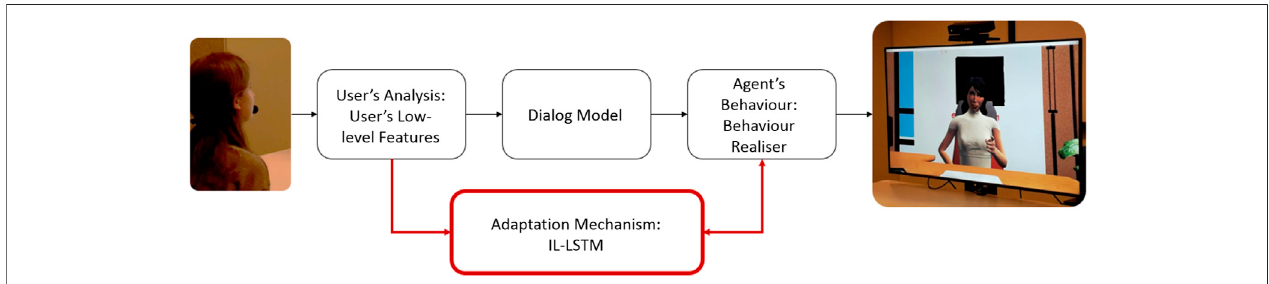
FIGURE 5 | Modi fi ed system architecture used in Study 3. In particular, the User ’ s Analysis module detects the user ’ s low-level signals such as head and eye rotations and lip corner activity. The Adaptation Mechanism module exploits the IL-LSTM model for selecting the agent ’ s low-level signals. In the Agent ’ s Behavior module,theBehaviorRealizeriscustomizedinordertotakeintoaccounttheagent ’